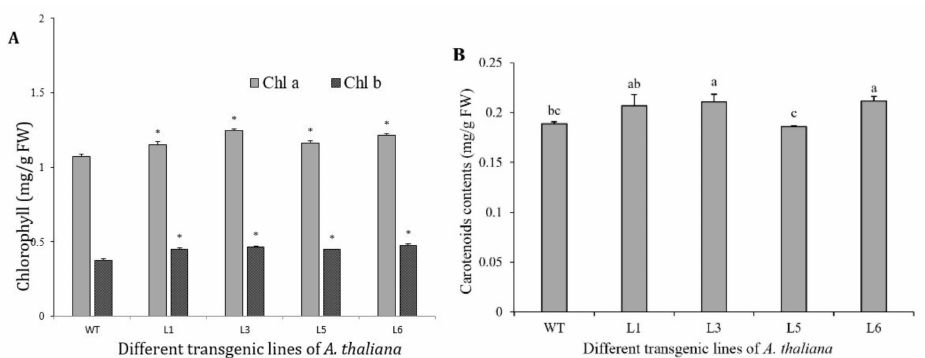
Figure 9. Contents of chlorophylls and carotenoids in transgenic A. thaliana seedlings carrying the SaDXR transgene. ( A ) Contents of chlorophyll a (Chl a ), chlorophyll b (Chl b ) and total chlorophyll in transgenic A. thaliana plants. ( B ) Content of carotenoids in 35S::SaDXR transgenic lines. Each value represents the means of three independent biological replicates ± SD. Different letters above bars indicate significant differences for each Chl type relative to WT (DMRT, p <